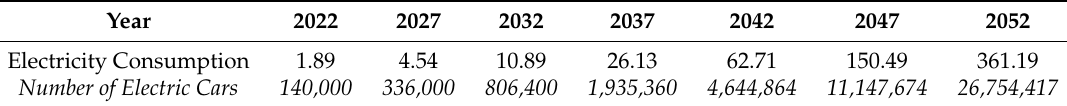
Table 6. MOREECAR scenario electric cars’ lower electricity consumption bounds